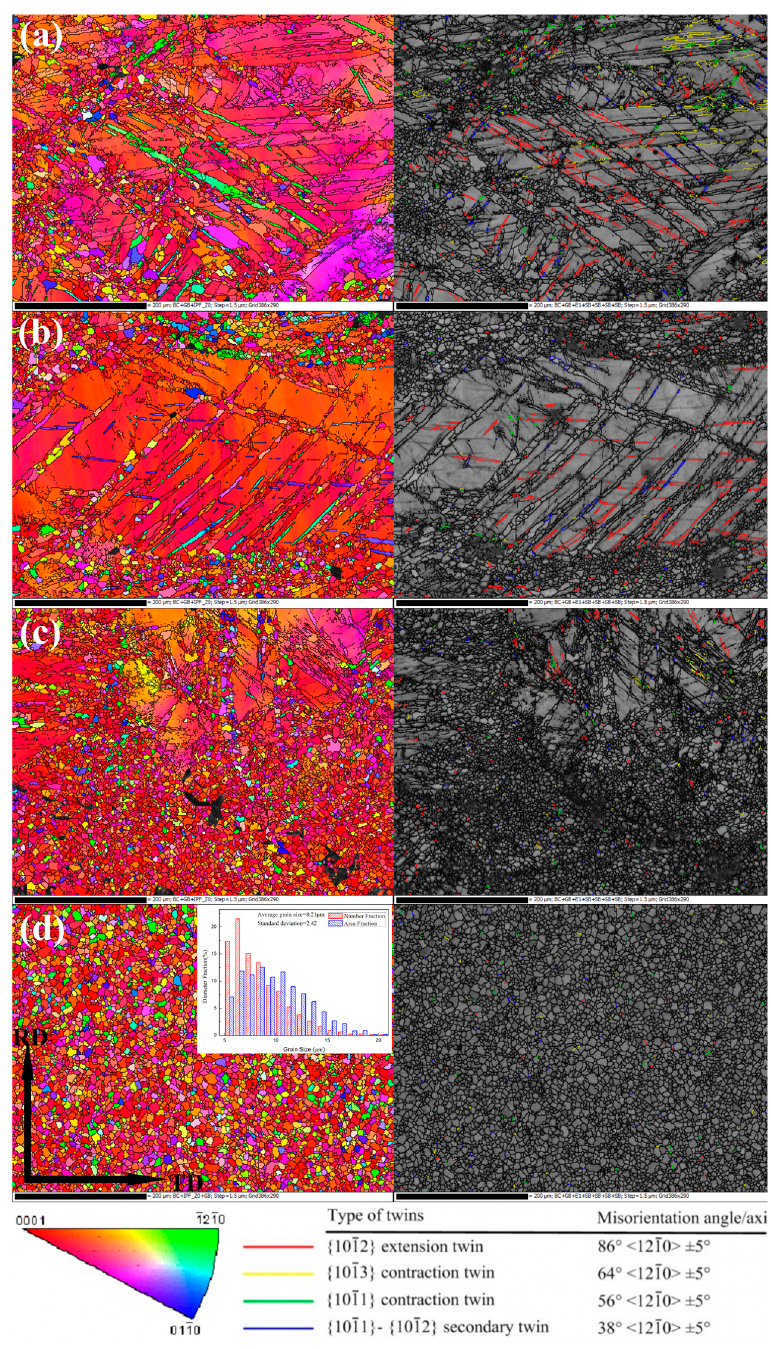
Figure 3. Inverse pole figures and boundary misorientation maps of AZ31 alloys HSRMFed to different accumulated strains with pass strain of Δ ε = 0.22 ( a ) 0.22, ( b ) 0.44, ( c ) 0.88 and ( d ) 1.32.